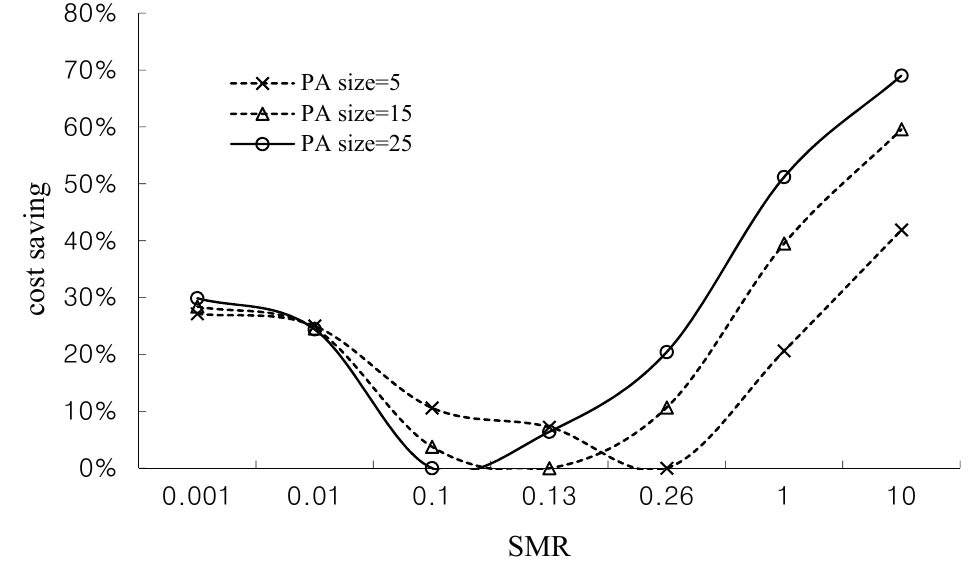
Figure 10. Cost saving of AHSIP according to